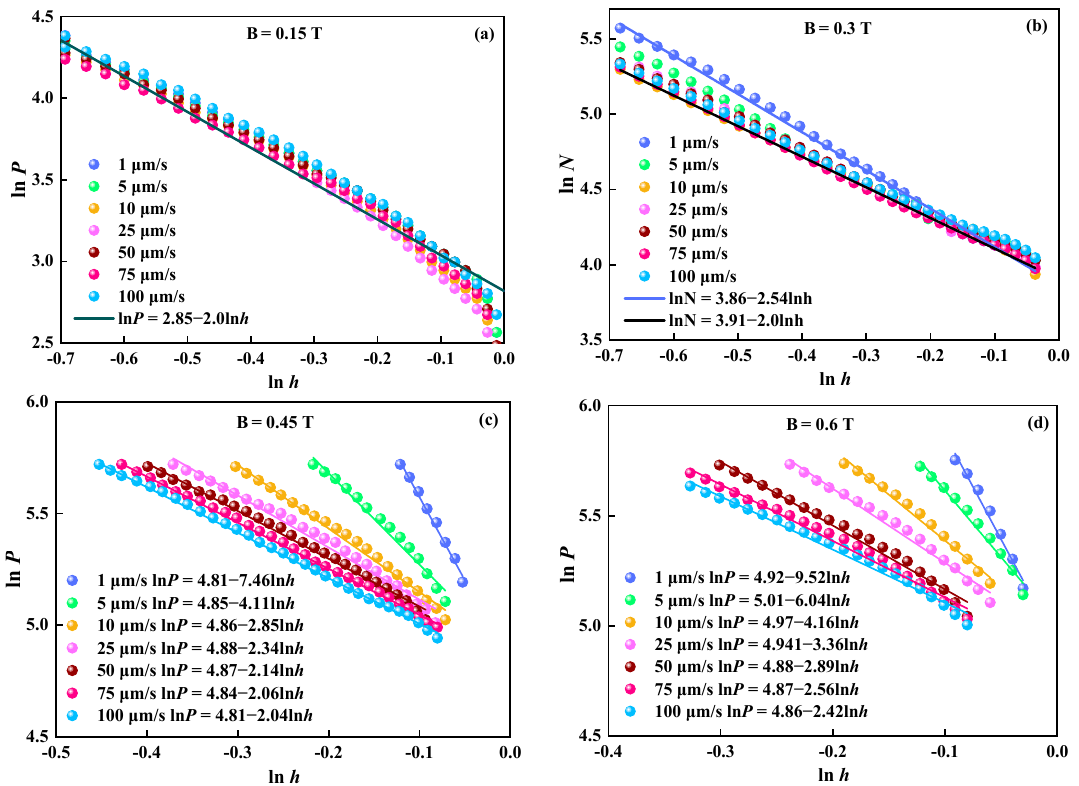
Figure 5. Logarithmic curves of compressive stress with different compressive speeds. ( a ) B = 0.15 T; ( b ) B = 0.3 T; ( c ) B = 0.45 T; ( d ) B = 0.6 T. When B = 0.3 T, the curves at different v overlap for the most part except for that of v = 1 µ m/s and v = 5 µ m/s, as shown in Figure 5b. As shown, a good linear relationship is theoretically predicted with a slope of 2 in the plastic flow process for v from 100 to 10 µ m/s. Additionally, the curve of v = 1 µ m/s fitted with a slope of − 2.43 is shown in Figure 5b. When B = 0.45 T, the slopes are 2.04 (100 µ m/s), 2.06 (75 µ m/s), 2.14 (50 µ m/s), 2.34 (25 µ m/s), 2.85 (10 µ m/s), 4.11 (5 µ m/s), and 7.46 (1 µ m/s), as shown in Figure 5c. According to Equation (8), it seems that the slopes are dependent on neither B nor v . However, Figure 5c shows that the experimental slopes are no longer in agreement